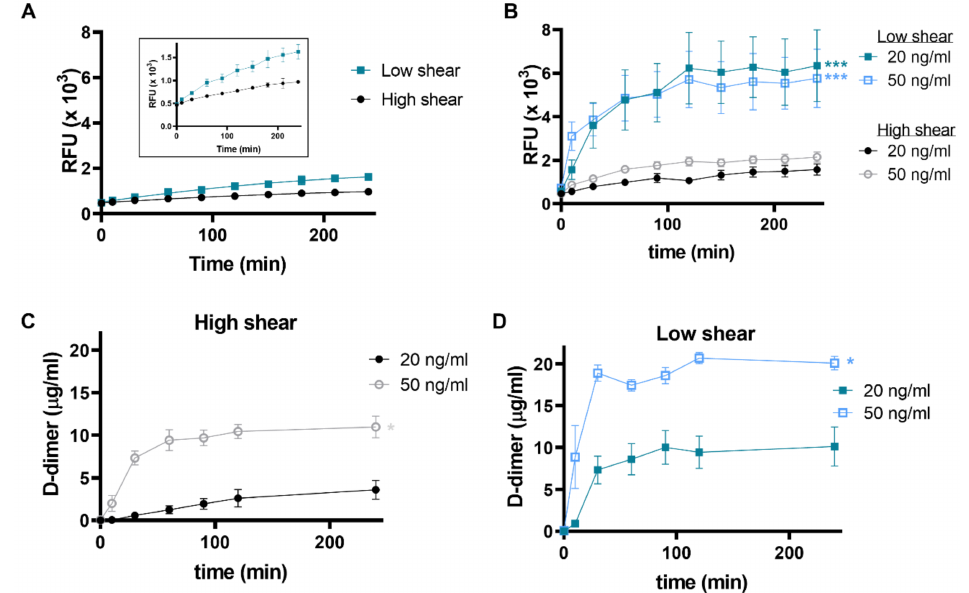
Figure 4. Fibrinolysis under high and low shear conditions. Whole blood thrombi were formed in Badimon chambers on a thrombogenic surface under low (212 s − 1 ) and high (1690 s − 1 ) shear rates. Fibrinolysis was measured as fluorescence release in the bathing fluid over time. Thrombi formed in the ( A ) absence or ( B ) with the incorporation of tPA at 20 or 40 ng/mL ( B ). D-dimer levels were measured at ( C ) high and ( D ) low shear rates. Data shown are mean ± SEM ( n =